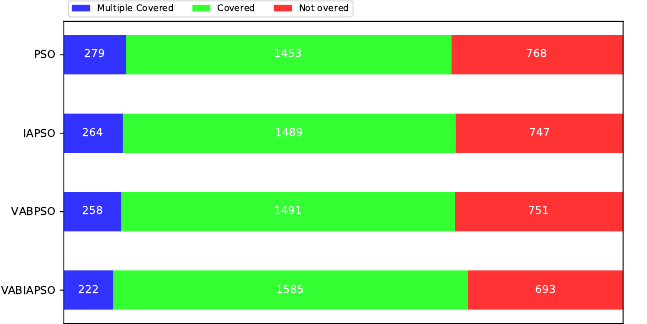
Figure 14. Performance comparison of four algorithms under the optimal parameters of the real